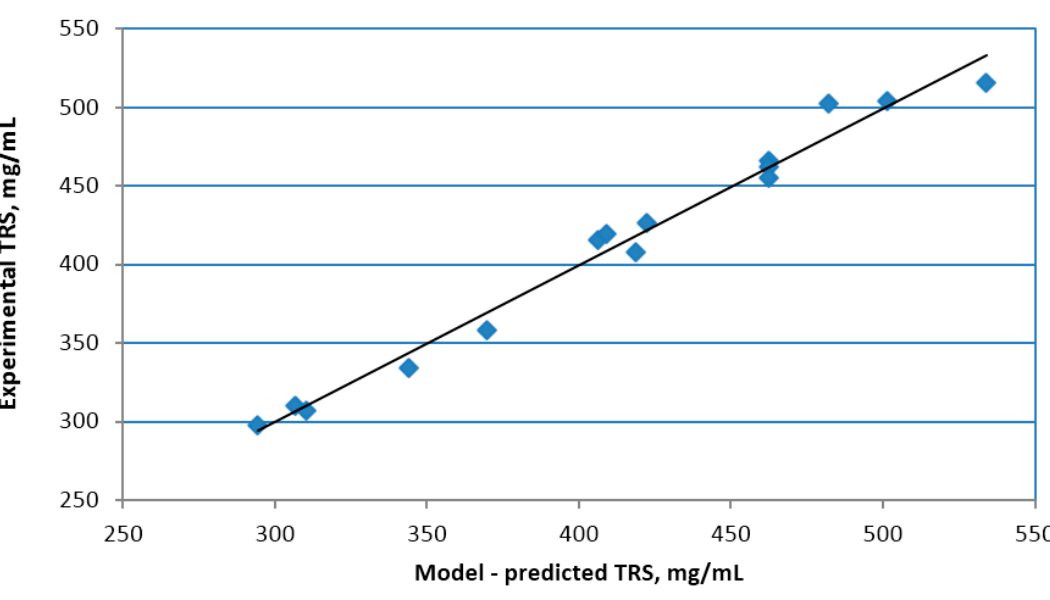
Figure 3. Analysis of variance for the theoretical (model-predicted) and experimental TRS yield.